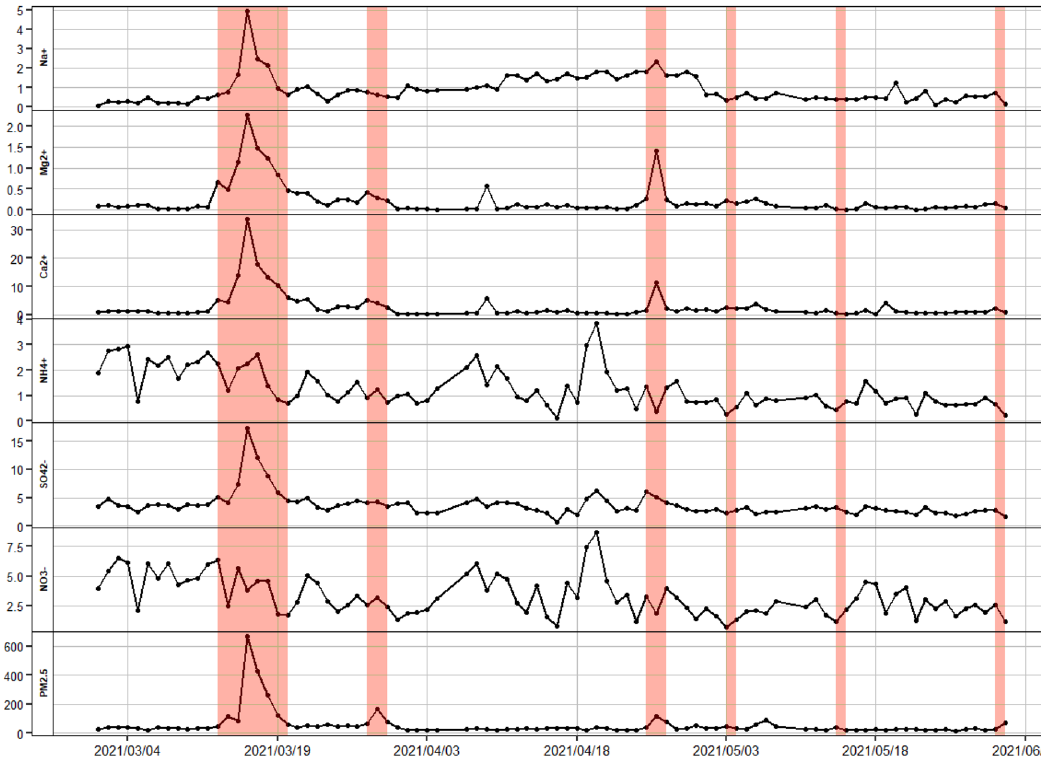
Figure 2. Time series of PM 2.5 and the water-ion concentrations from March 1, 2021, to May 31, 2021, in Lanzhou, China (colored bars indicate dust storm days).